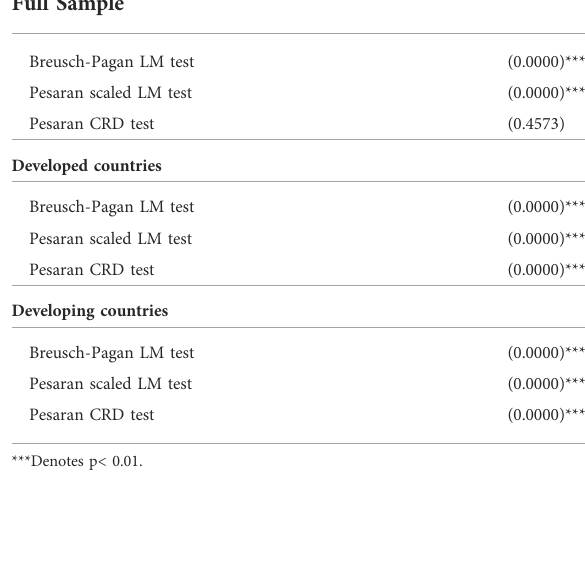
TABLE 3 Unit root test.